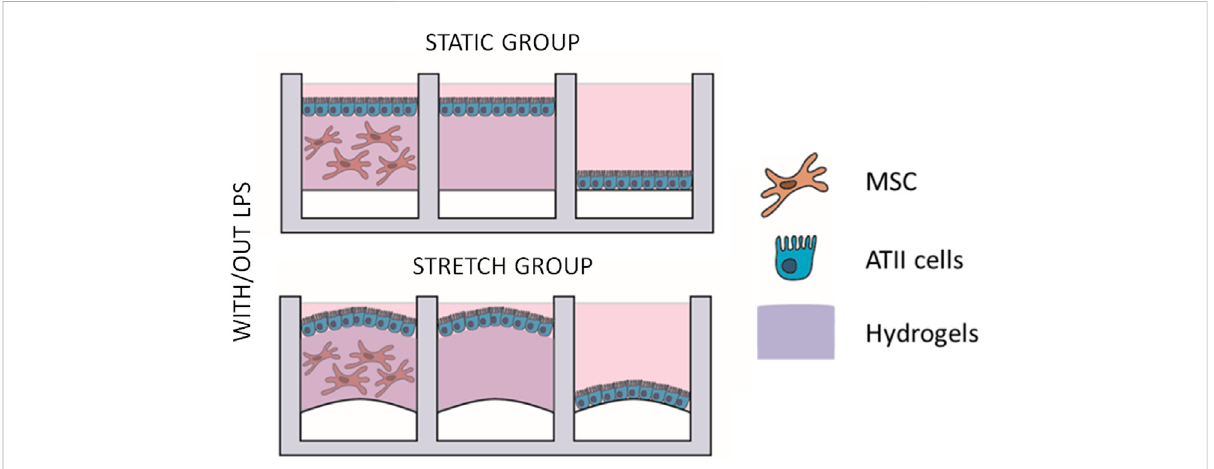
FIGURE 3 Four different experimental groups were designed. In every chip, three different cultures were performed: ATII-LMSC cocultured with/out 3D- cultured LMSC and an ATII monolayer on the hydrogels; ATII single culture monolayer on the hydrogel; and single culture ATII monolayer on the PDMS membrane. In every run of experiments, four chips were used, each of which was subjected to different conditions: static group, static group with an LPS hit, cyclic stretch group, and cyclic stretch group with an LPS